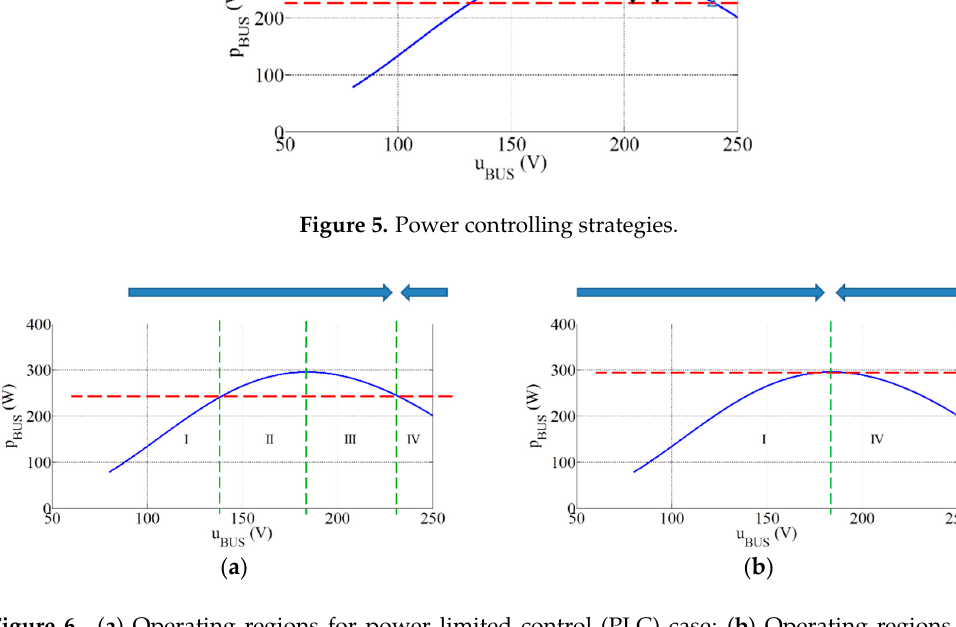
Figure 6. ( a ) Operating regions for power limited control (PLC) case; ( b ) Operating regions for maximum power point tracking (MPPT) case. Table 2. Definition of four operating regions for PLC case.